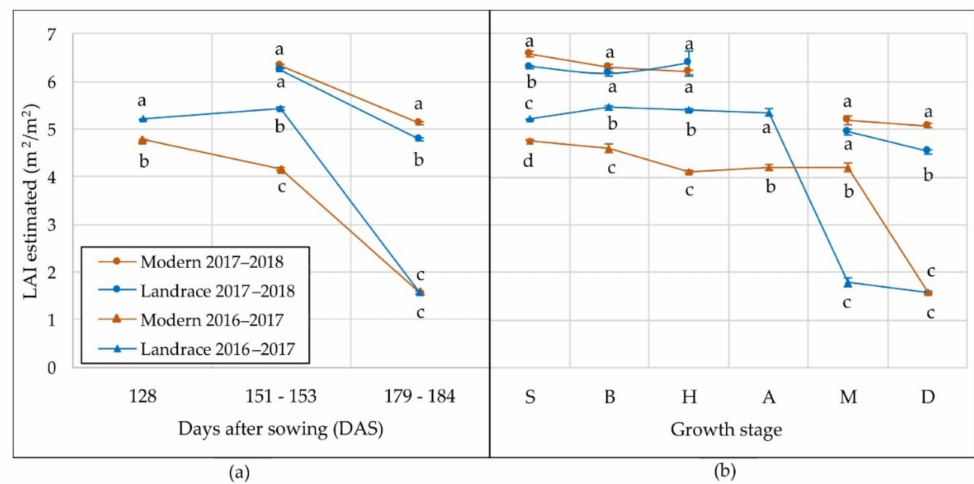
Figure 4. Mean values in 2017 and 2018 of leaf area index estimated through MTVI2 for landraces and modern cultivars at: ( a ) each date of image acquisition expressed in days after sowing (DAS), and ( b ) each growth stage. S, stem elongation; B, booting; H, heading; A, anthesis; M, milk-grain development; D, hard dough-grain development. Different letters at each date or growth stage indicate significant differences at p ≤ 0.01 using Tukey’s honest significant difference